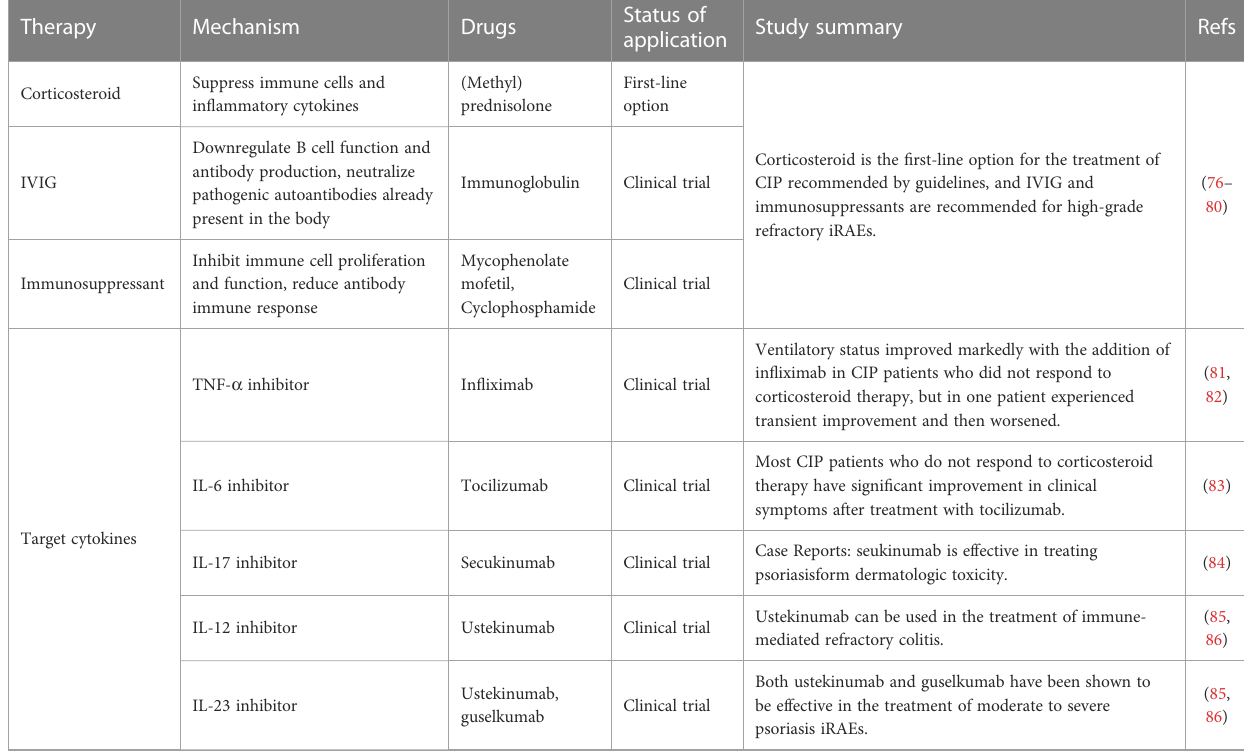
TABLE 1 Management and treatment strategies of